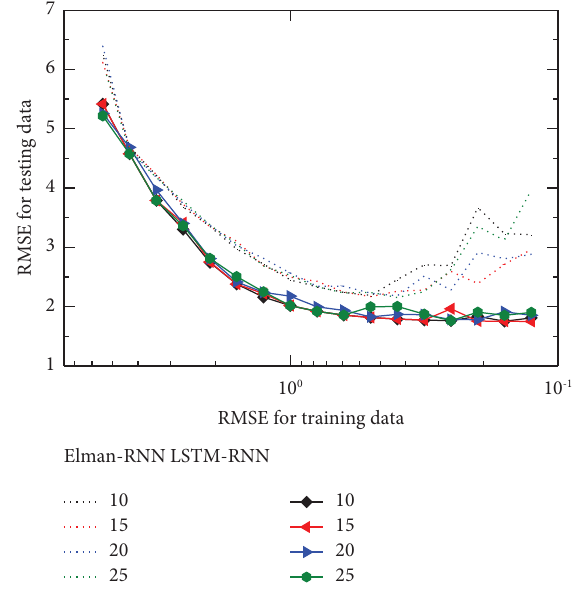
Figure 9: Average testing RMSE vs. training RMSE by prediction models based on LSTM models (compared with the Elman neural network